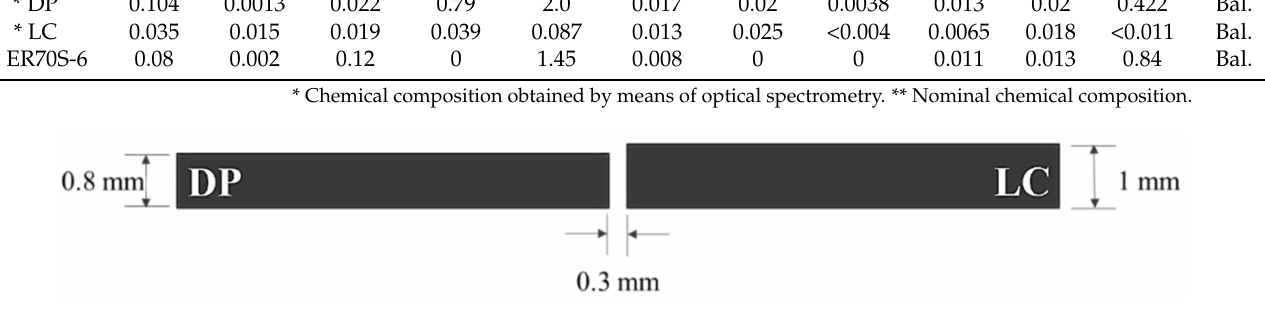
Figure 1. Welded joint